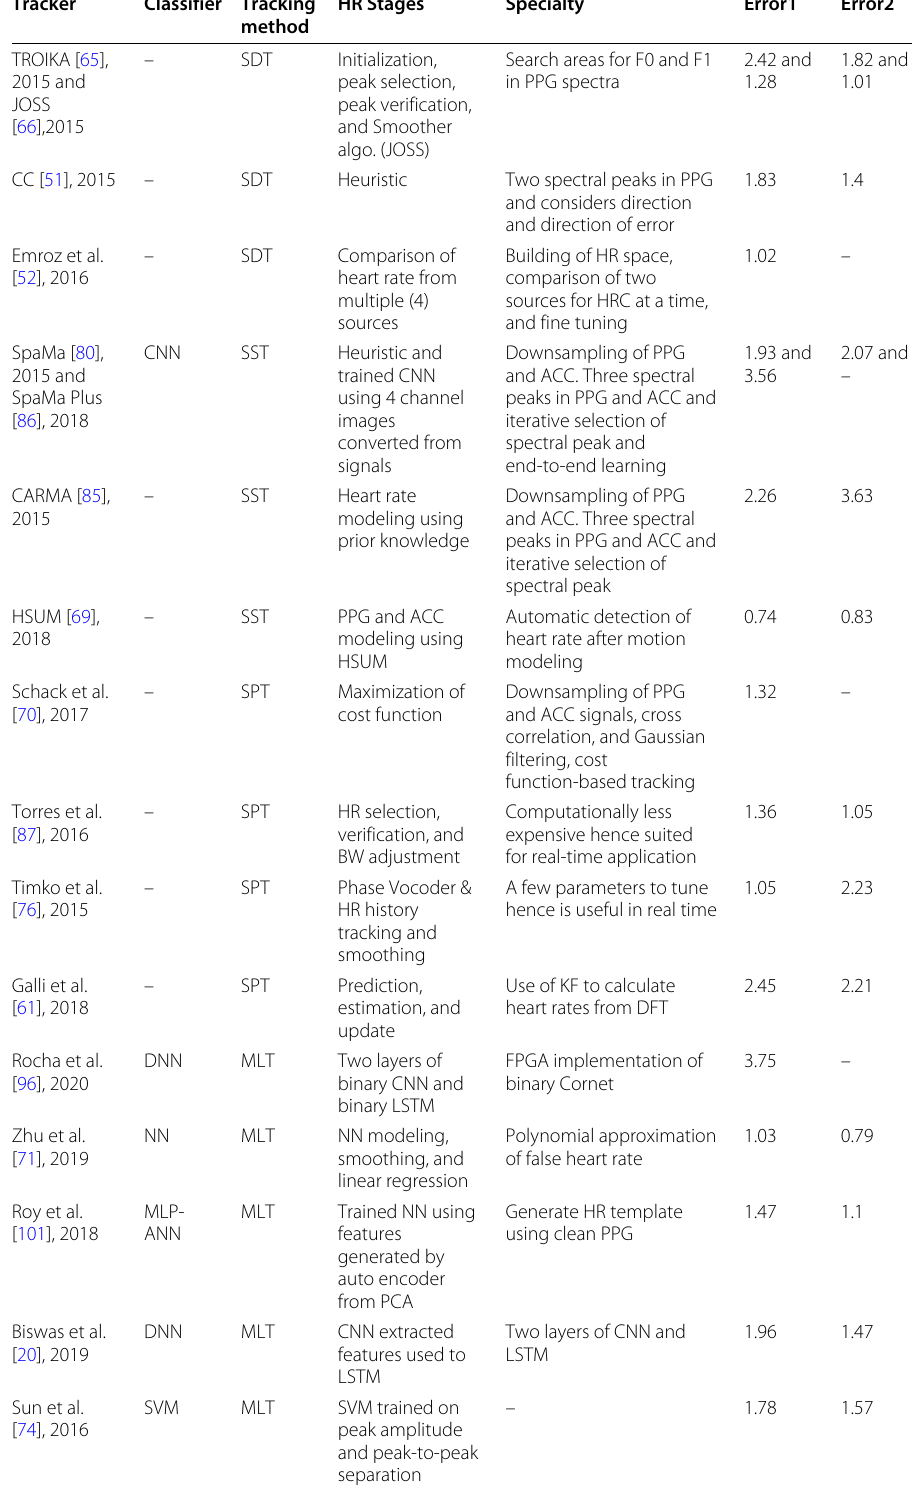
Table 2 An overview of HR tracking techniques Tracker Classifier Tracking